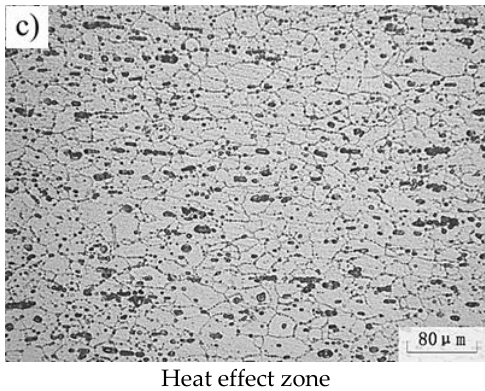
Figure 7. Optical microscopy of solution treated and aged 6061-T6 joints.